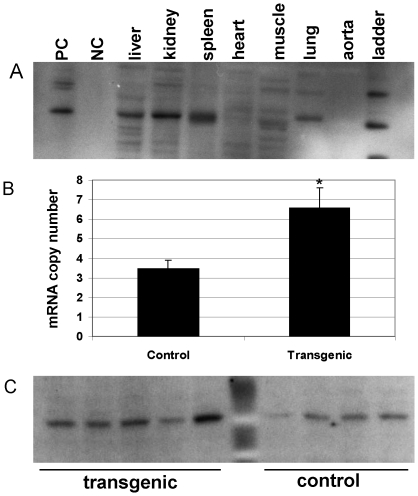
Characterization of Soat1 transgenic mice.A, expression of Soat1 protein in transgenic mice. PC, positive control: lane loaded with Soat1 protein; NC, negative control: lane loaded with buffer only. B, real-time PCR analysis of Soat1 mRNA expression in the liver of transgenic and non-transgenic (control) littermates. The expression level of Soat1 was expressed as copy number relative to 10,000 copies of GAPDH mRNA. Results are means ± SE of 6 and 5 transgenic and non-transgenic mice, respectively. C, expression of Soat1 protein in the liver of transgenic and non-transgenic littermates. Each lane represents an individual mouse.